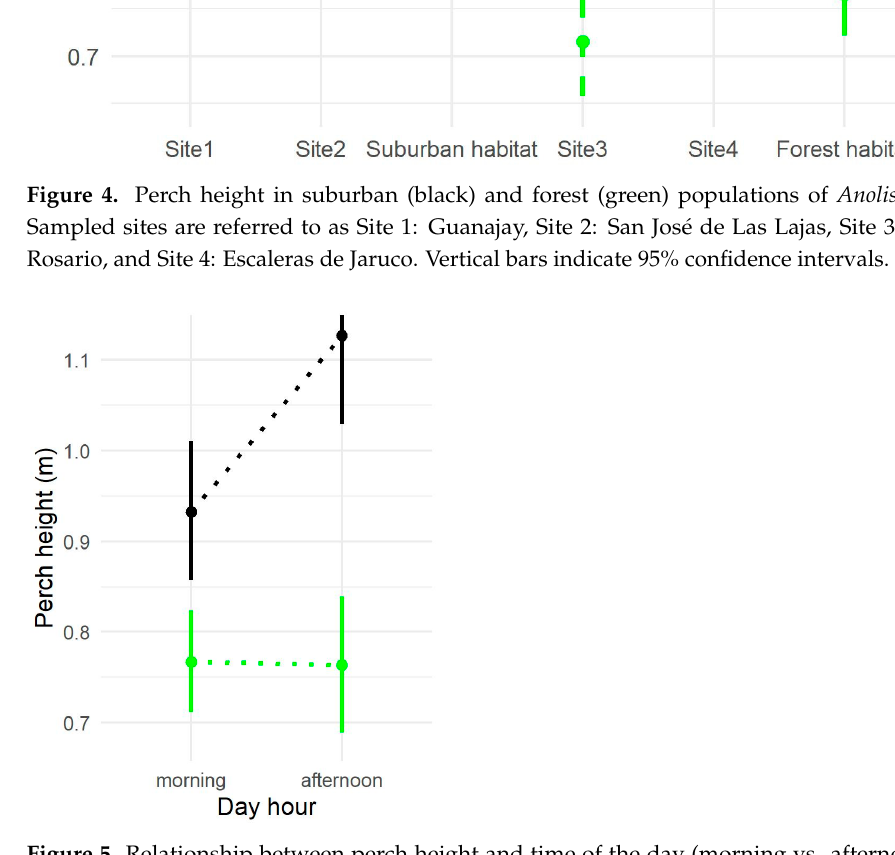
Figure 5. Relationship between perch height and time of the day (morning vs. afternoon) in suburban (black) and forest (green) populations of Anolis homolechis . Vertical bars indicate 95% confidence intervals.